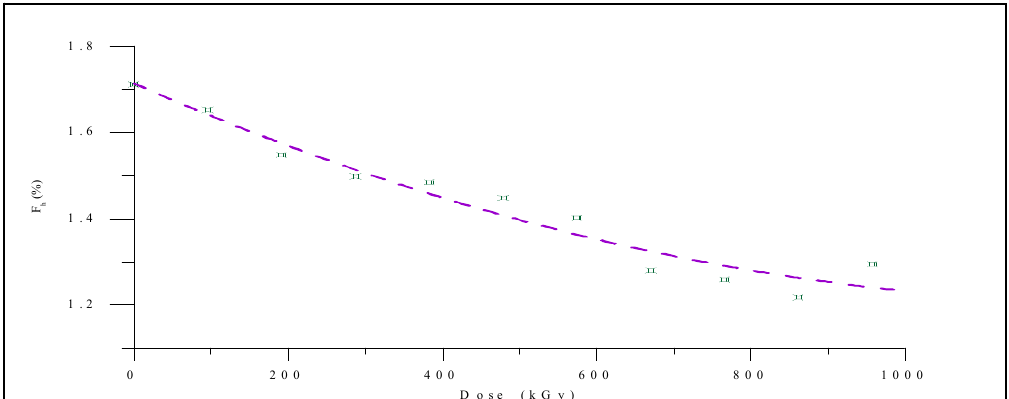
Fig. 5: Fh for EP as a function of γ